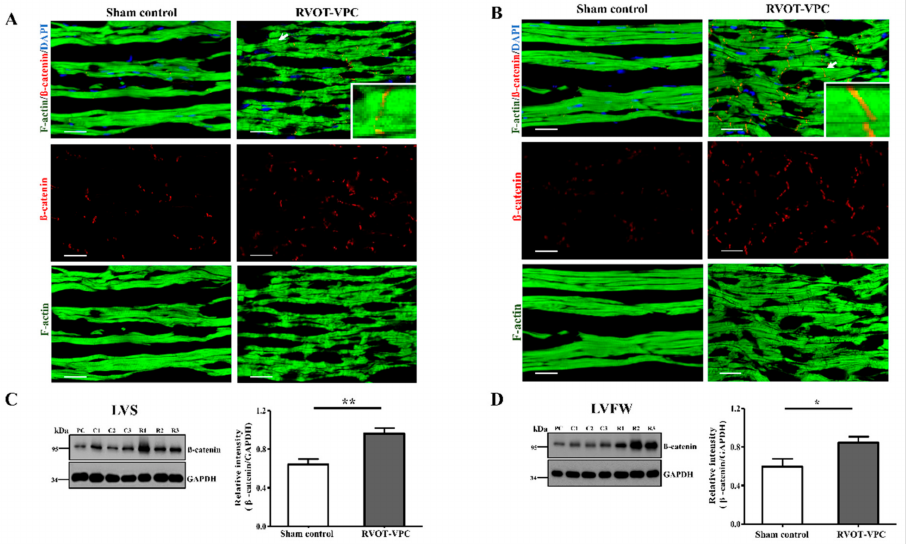
Figure 4. Immunohistological and immunoblotting studies of the expression of β -catenin in the RVOT-VPC group and sham control group at left ventricular septum (LVS A , C ) and left ventricular free wall (LVFW B , D . The expression of β -catenin at intercalated discs significantly increased in the RVOT-VPC group than in the sham control group at LVS ( A , C ) and LVFW ( B , D ). In addition, the spindle-shape actin accumulation was located at the intercalated discs with β -catenin (insert) (white arrow at right upper panel in ( A , B ). DAPI staining for nuclei. Scale bar = 10 µ m. *: p < 0.05 and **: p < 0.01. PC: positive